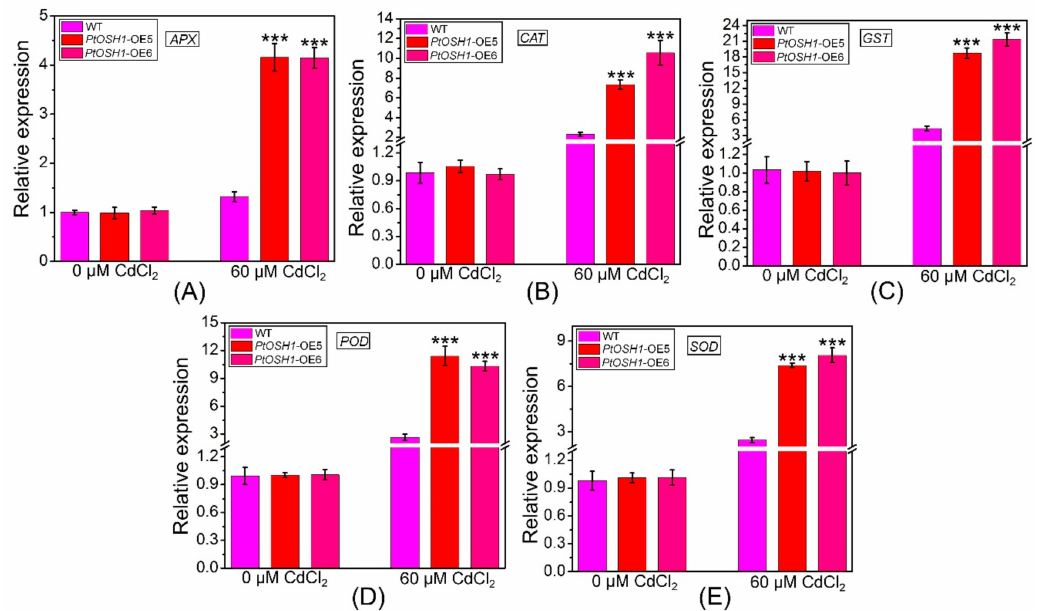
Figure 7. Transcript levels of ascorbate peroxidase ( APX ) ( A ), catalase ( CAT ) ( B ), glutathione S-transferase ( GST ) ( C ), peroxidase ( POD ) ( D ), and superoxide dismutase ( SOD ) ( E ) before and after exposure to 60 µ M Cd 2 + . Data are 2 – ∆∆ Ct levels relative to WT plants and normalized to the transcript level of AtActin . Three independent biological experiments were performed with three technical repeats. One-way ANOVA and Tukey’s test were used to evaluate significant di ff erences. Vertical bars represent the means ± SD (n = 3). ***, Significant di ff erence at p < 0.001. Accession numbers: APX (NM_119666.4), CAT (NM_119675.4), GST (NM_128499.5), POD (NM_119917.3), and SOD (NM_001084025.1).